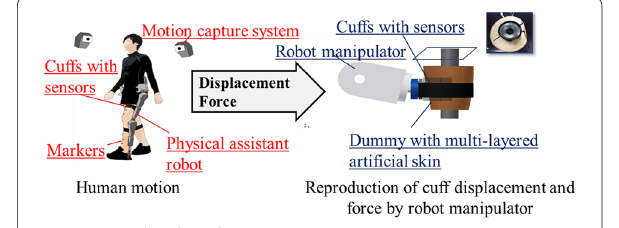
Fig. 1 Wounds risk evaluation process [19]